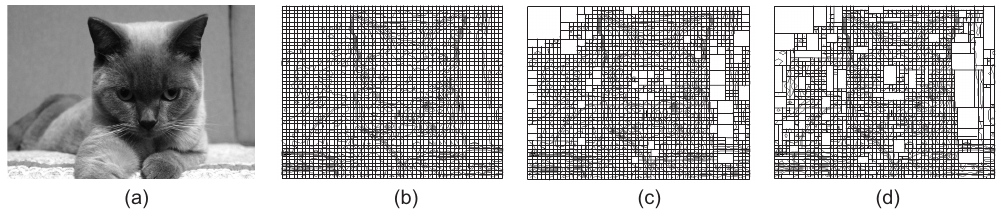
Figure 1. The original image of the Cat and the partitioned images with edge overlaying the partitions by three different range block partition methods: ( a ) original image; ( b ) partitioned image by uniform partition; ( c ) partitioned image by uniform partition quadtree partition; and ( d ) partitioned image by HV